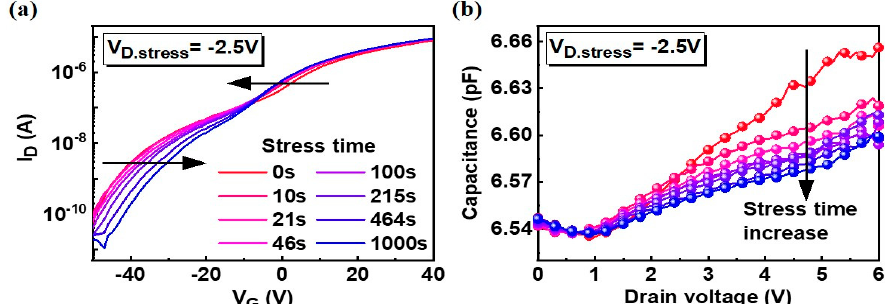
Figure 3. ( a ) I D –V G transfer curves after negative bias stress. V D.stress = − 2.5 V and stress time = 1000 s. Curves were shifted from the red to the blue line as indicated by the arrows; ( b ) gradual change in the source to drain capacitance as a function of drain voltage during the constant voltage stress. Capacitance was measured at V G = 0 V.